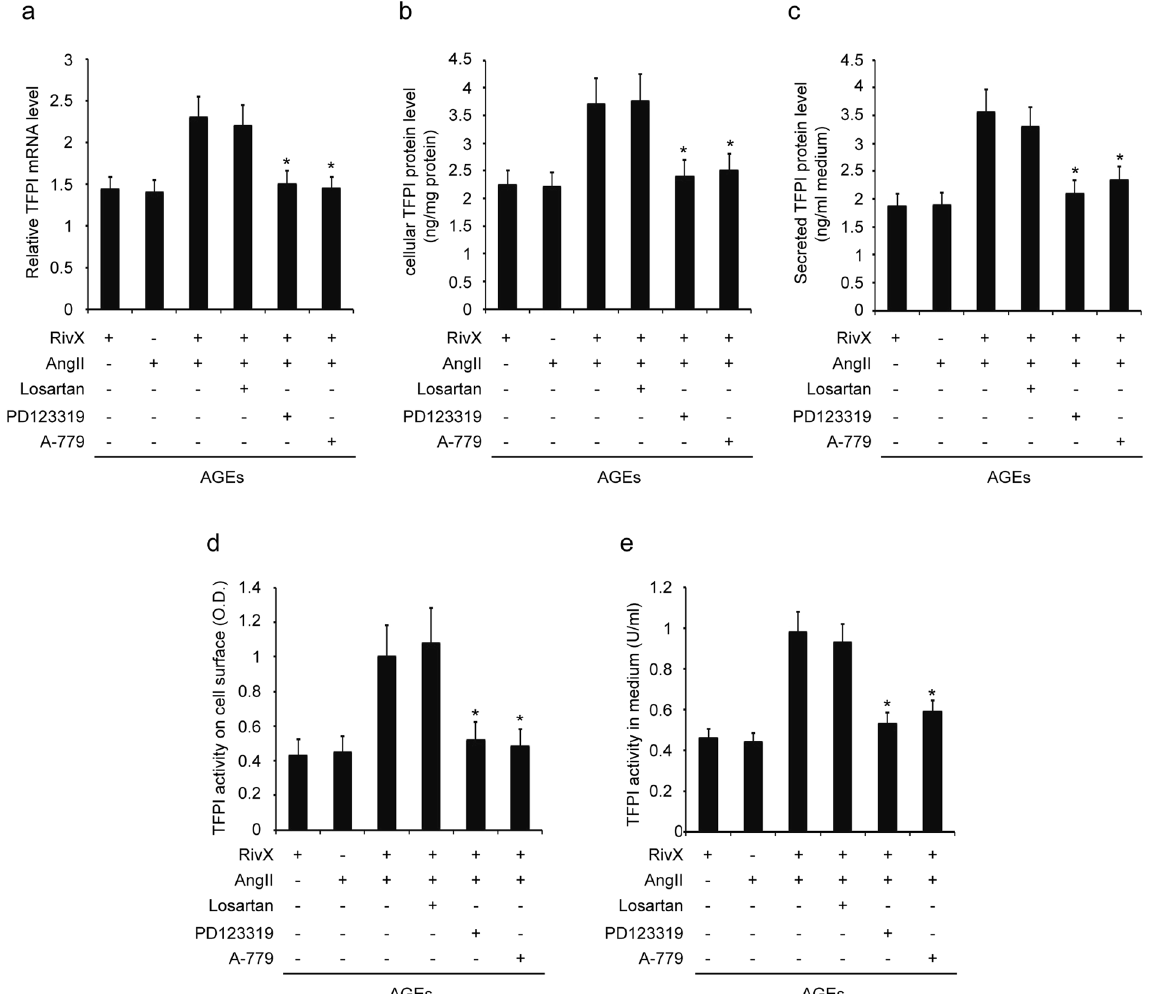
rivaroxaban (RivX) or AngII (200 nM) in the presence of AT1R antagonist Losartan (1 µ M), or AT2R antagonist PD123319 (1 µ M), or Mas antagonist A-779 (1 µ M) for 4 h. ( a ) TFPI mRNA expression, ( b ) cellular TFPI protein, ( c ) TFPI secretion into the culture medium, ( d ) TFPI activity on the cell surface, and ( e ) TFPI activity in medium were measured. The bars show the mean ± SEM (n = 4). * P < 0.05 compared with the parallel group co-treated with RivX and